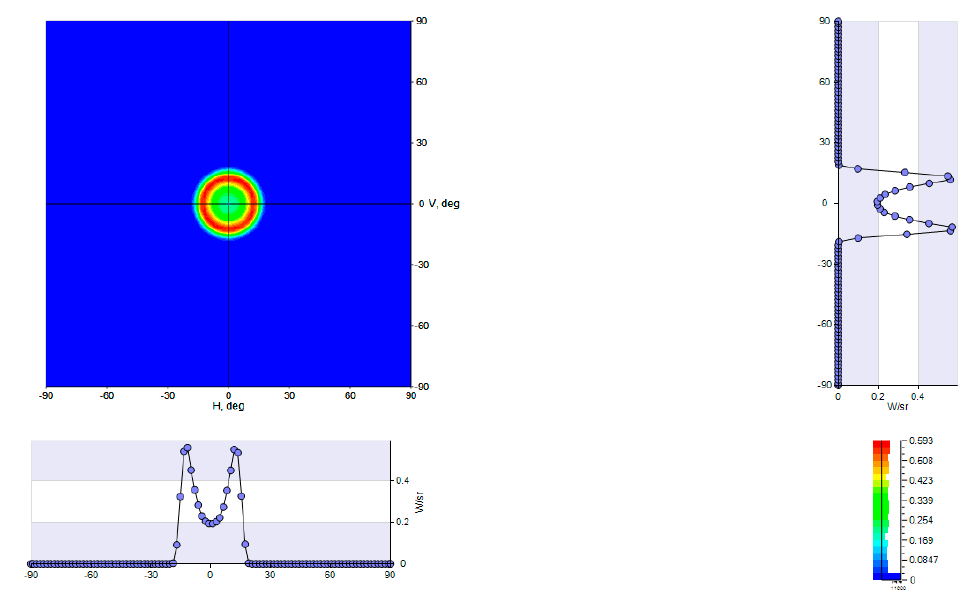
Figure 18. LENS pixel Intensity angular distribution output obtained with LightTools software .